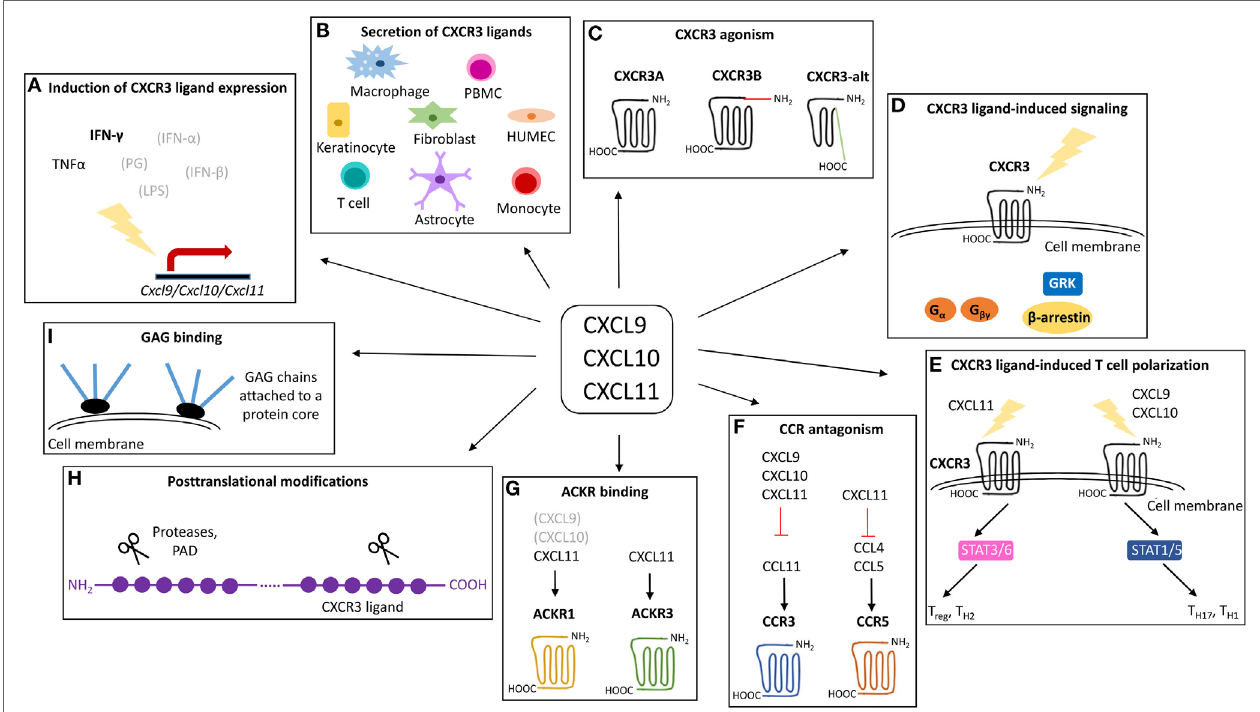
FiGuRe 2 | Overview of the mechanisms that may contribute to the exclusivity of CXCR3 ligands. CXCL9, CXCL10, and CXCL11 are structurally related chemokines that share CXCR3 as common receptor and IFN- γ as predominant inducer. Despite structural and functional similarities, emerging evidence points toward non-redundant roles for CXCL9, CXCL10, and CXCL11 in vivo . The exclusivity of individual IFN-inducible CXCR3 ligands may be rooted at multiple levels including secretion of specific IFN-inducible CXCR3 ligands by specific cell types in response to specific inducers (A,B) , specific CXCR3 interaction features and the existence of different CXCR3 isoforms (C) , major associated signaling cascades (D) , effects on T cell polarization (e) , CCR antagonism (F) , ACKR interactions (G) , posttranslational processing (H) , and GAG binding characteristics (i) . ACKR, atypical chemokine receptor; CCR, CC chemokine receptor; CXCR, CXC chemokine receptor; GAG, glycosaminoglycan; GRK, G protein-coupled receptor kinases; HUMEC, human microvascular endothelial cell; IFN, interferon; LPS, lipopolysaccharide; PAD, peptidylarginine deiminase; PBMC, peripheral blood mononuclear cell; PG, peptidoglycan; STAT, signal transducer and activator; TNF, tumor necrosis